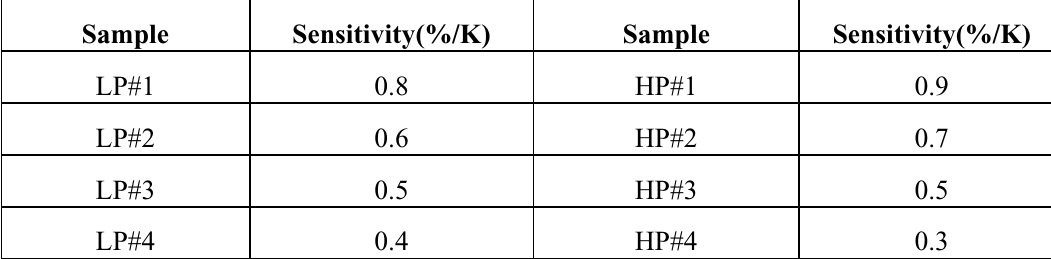
Figure 10. The relative resistance change expressed as a percentage against increasing O /SiO samples produced at high pressure. temperature for the In 2 3 Table 3. The temperature sensitivity of the sensor